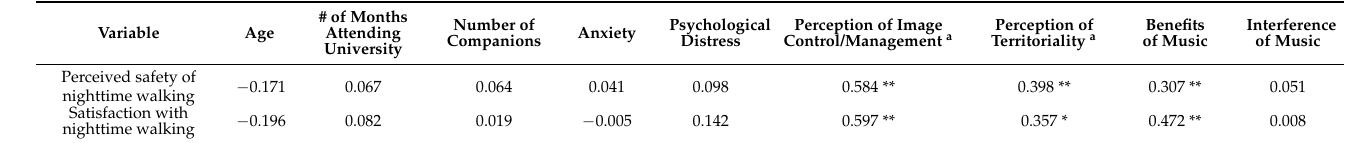
Table 9. Correlation between the perceived safety of campus and other measures for the music- listening group ( n = 78).